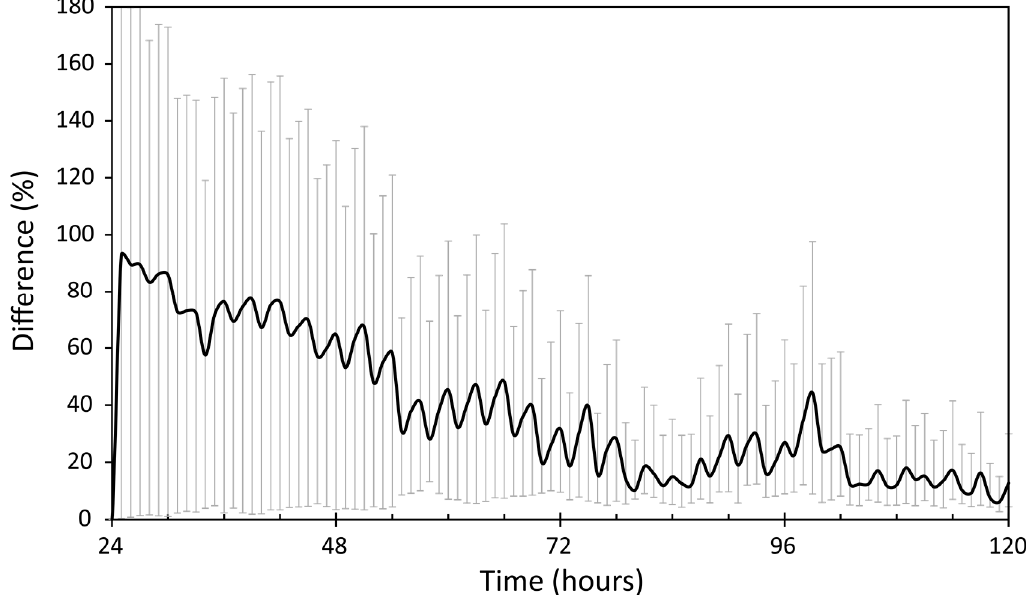
Figure 8. The difference between average maximum burden among neighbouring nodes estimated by each node with MaxBE, and the actual maximum burden in the network at different times during the simulation.